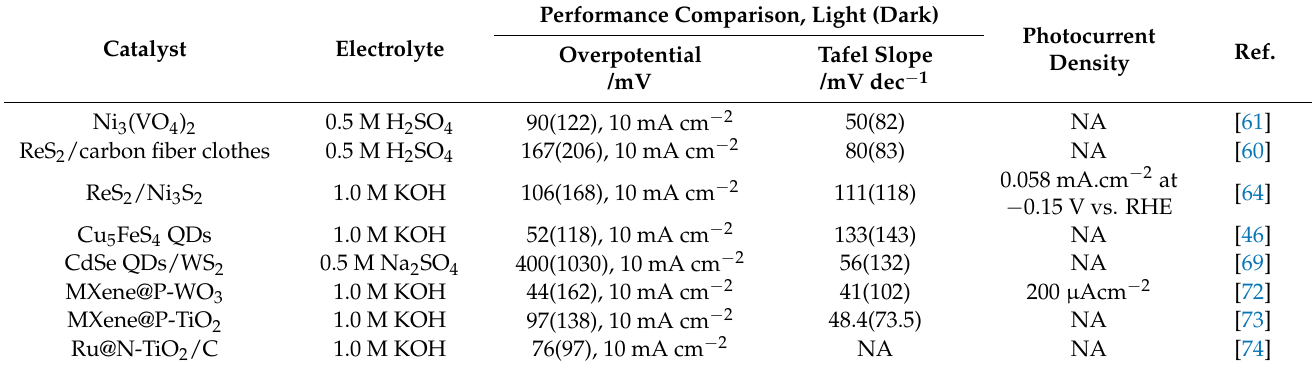
Table 1. Main catalysts and experimental conditions and activities of photogenerated carrier-assisted electrocatalysts for HER.